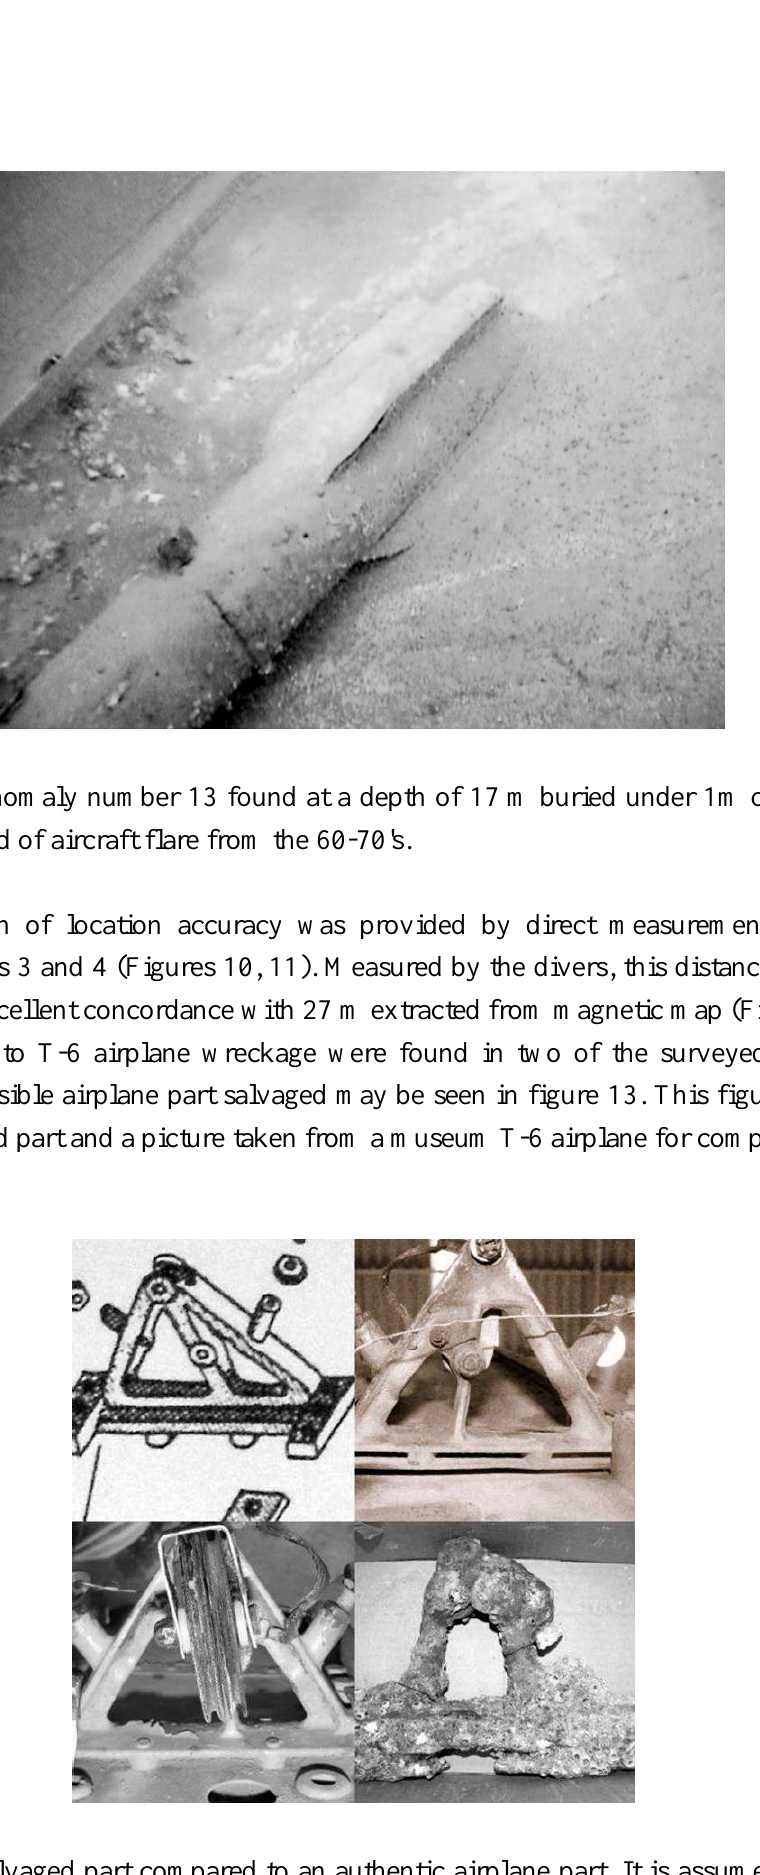
Figure 13. Salvaged part compared to an authentic airplane part. It is assumed to belong to the airplane tail assembly